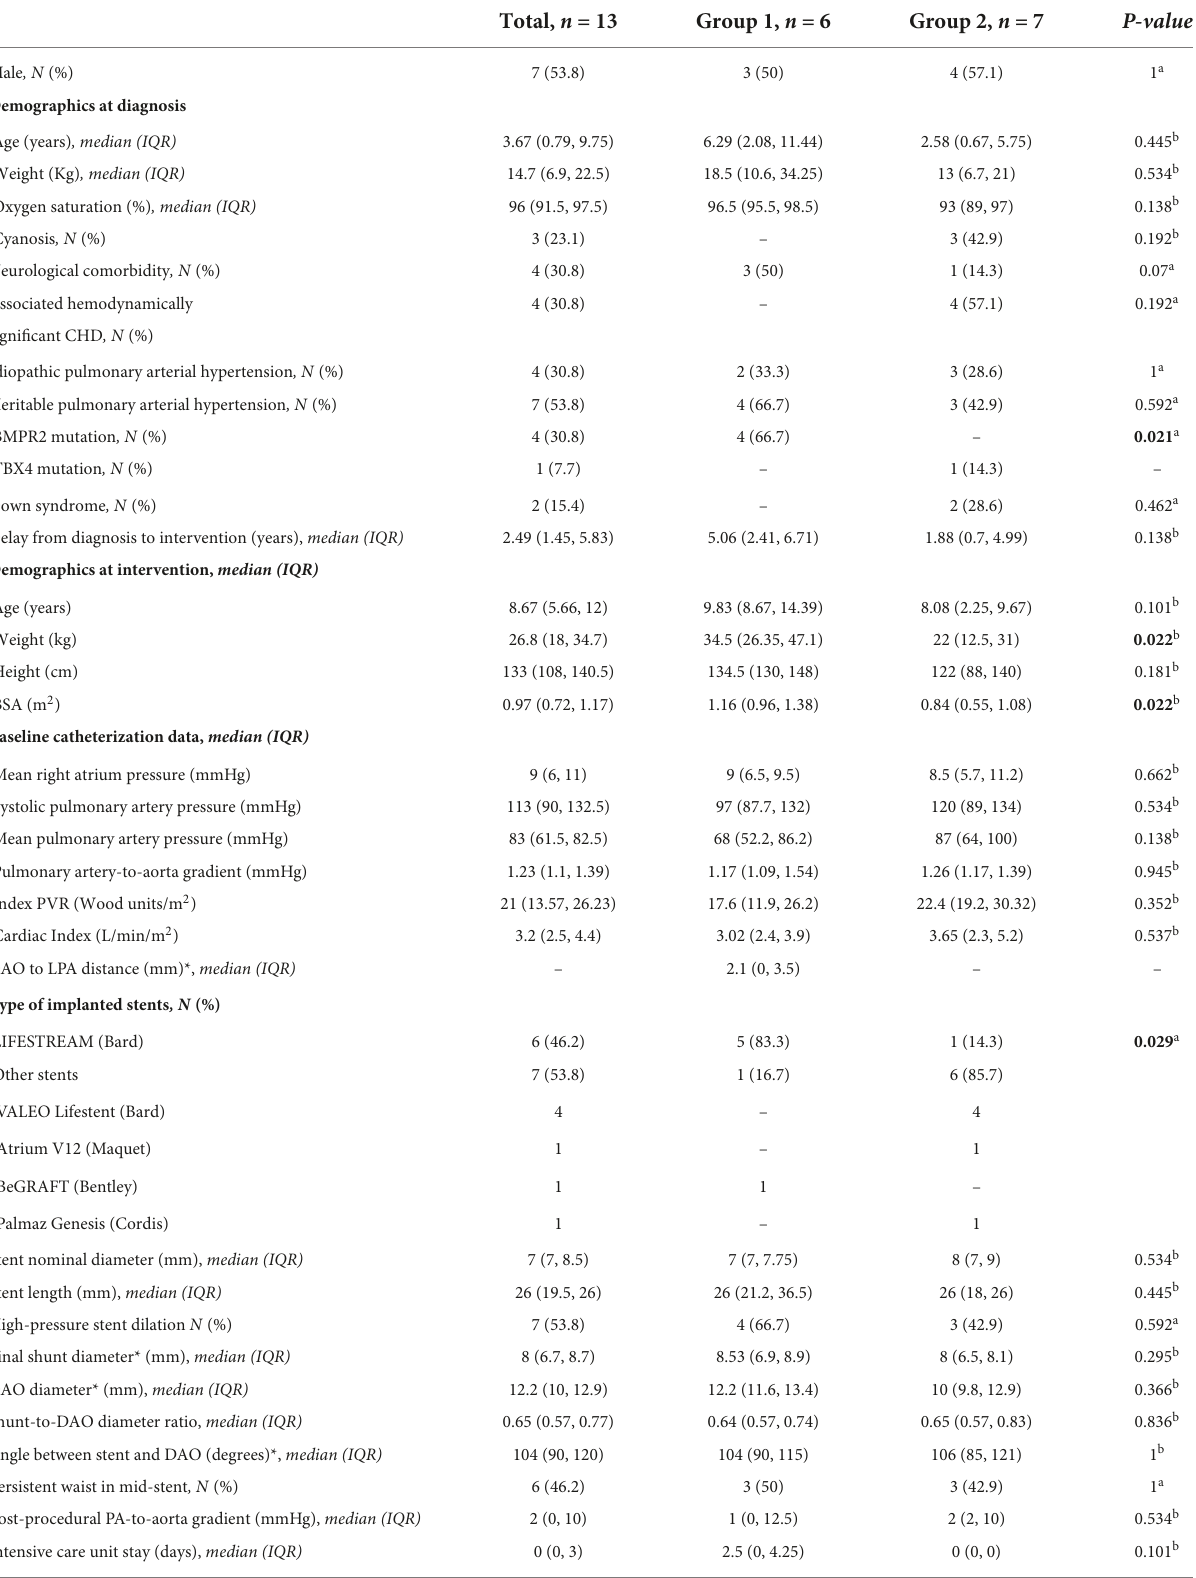
TABLE 1 Baseline clinical and procedural